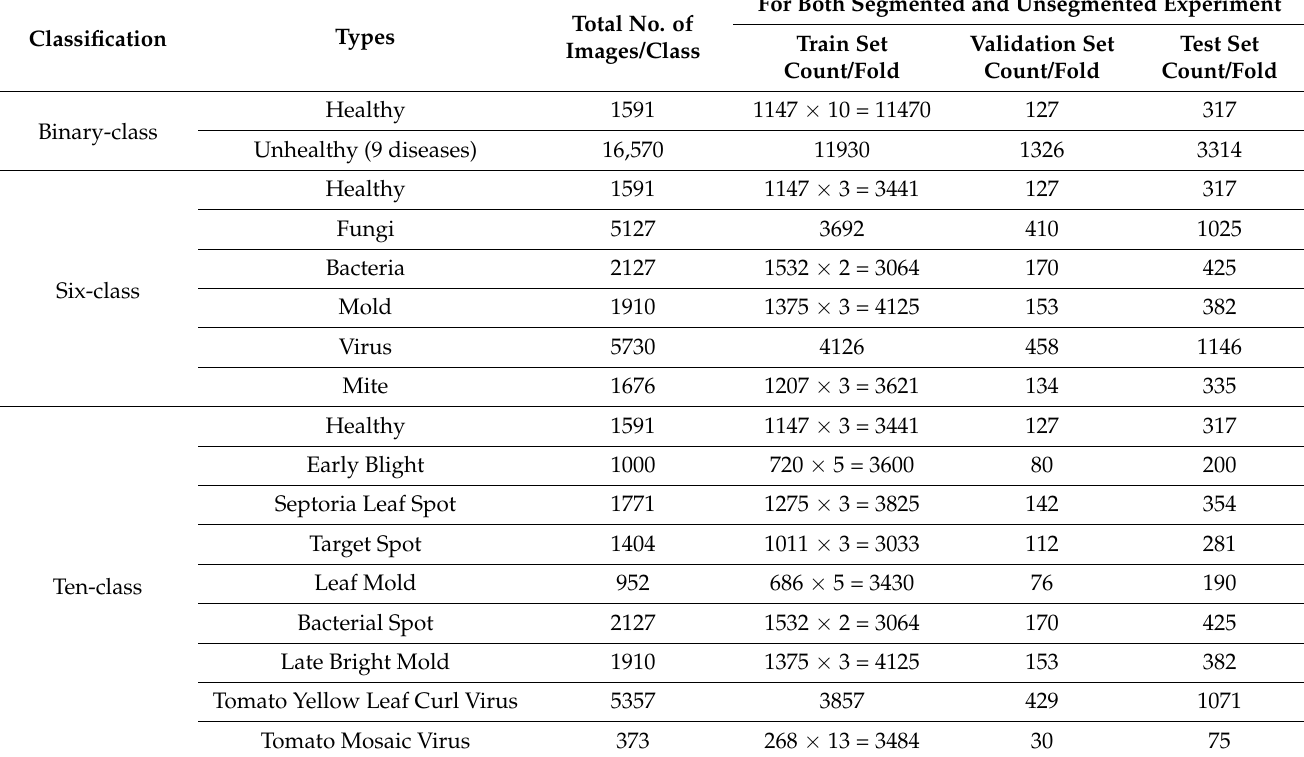
Table 4. Summary of different classification